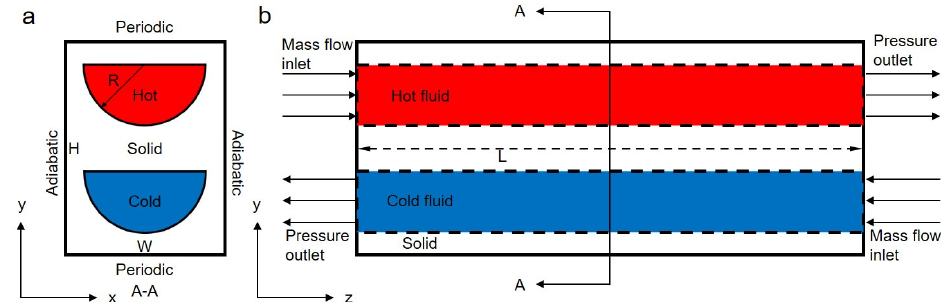
Figure 1. Boundary conditions and geometry configuration of a double bank unit in the straight PCHE. ( a ) Front view of cross section and ( b ) Side view along flow direction. The detail of geometry